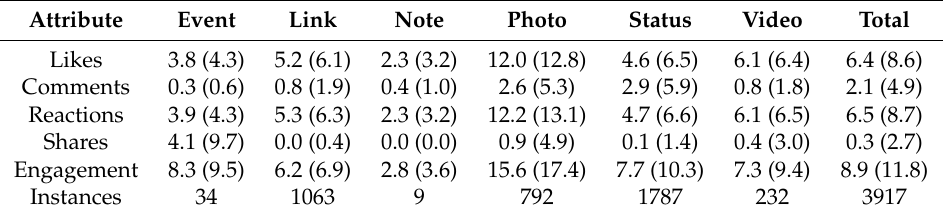
Table 2. Characterization of the dataset mean (std).